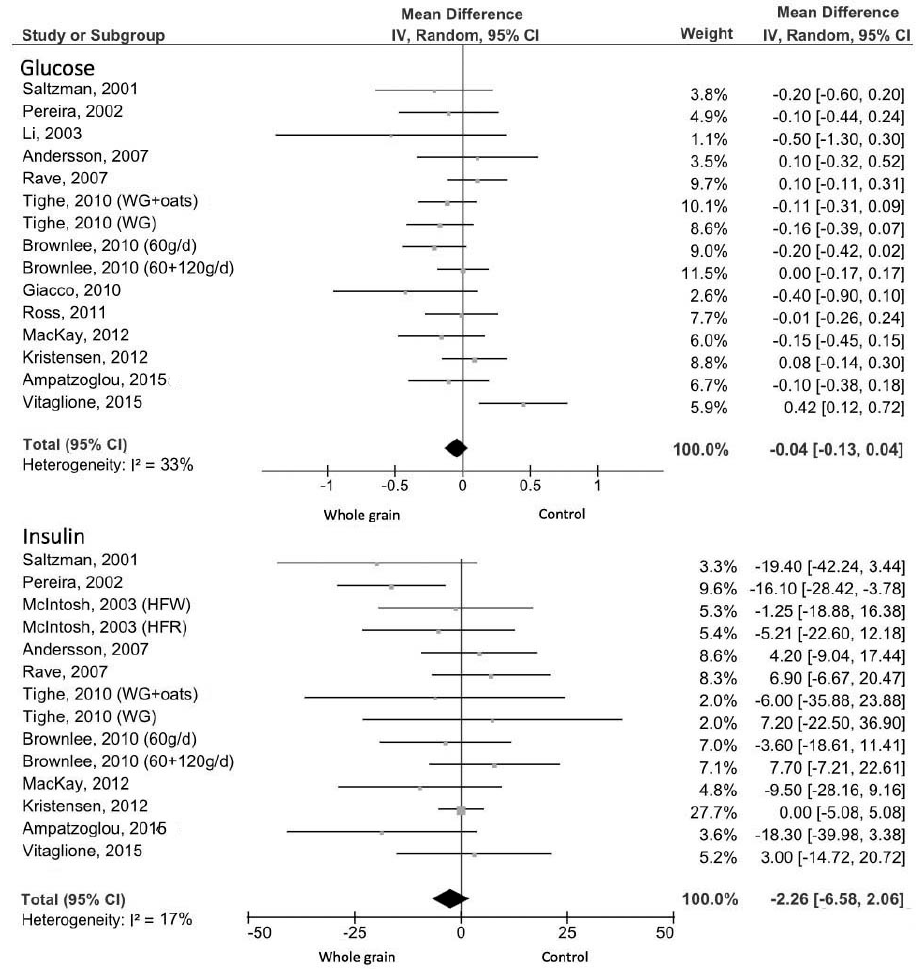
Figure 5. Forest plot of the meta-analysis carried out to investigate the effect of whole grain consumption on fasting glucose and insulin. WG, whole grain; HFW, high-fibre wheat; HFR, high-fibre rye.